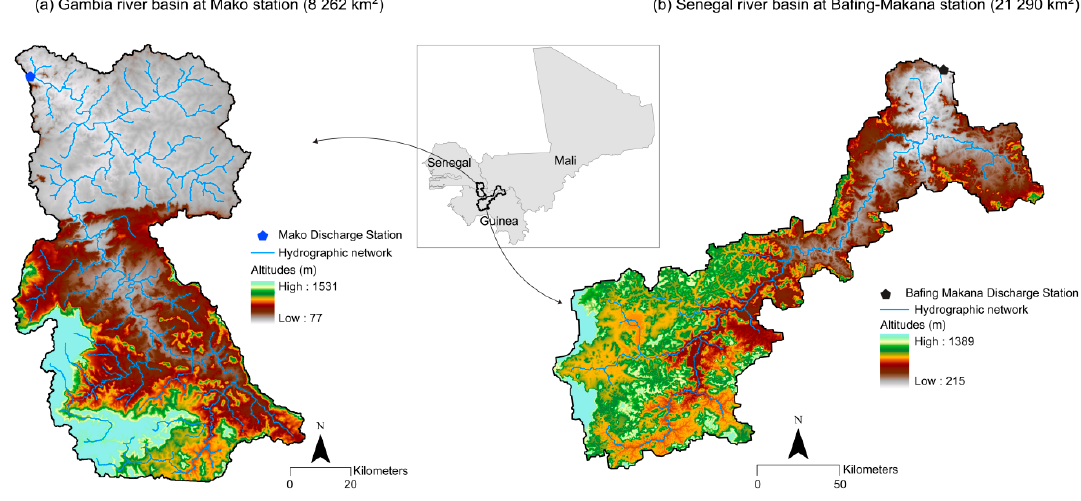
Figure 1. Situation map of the river basins.